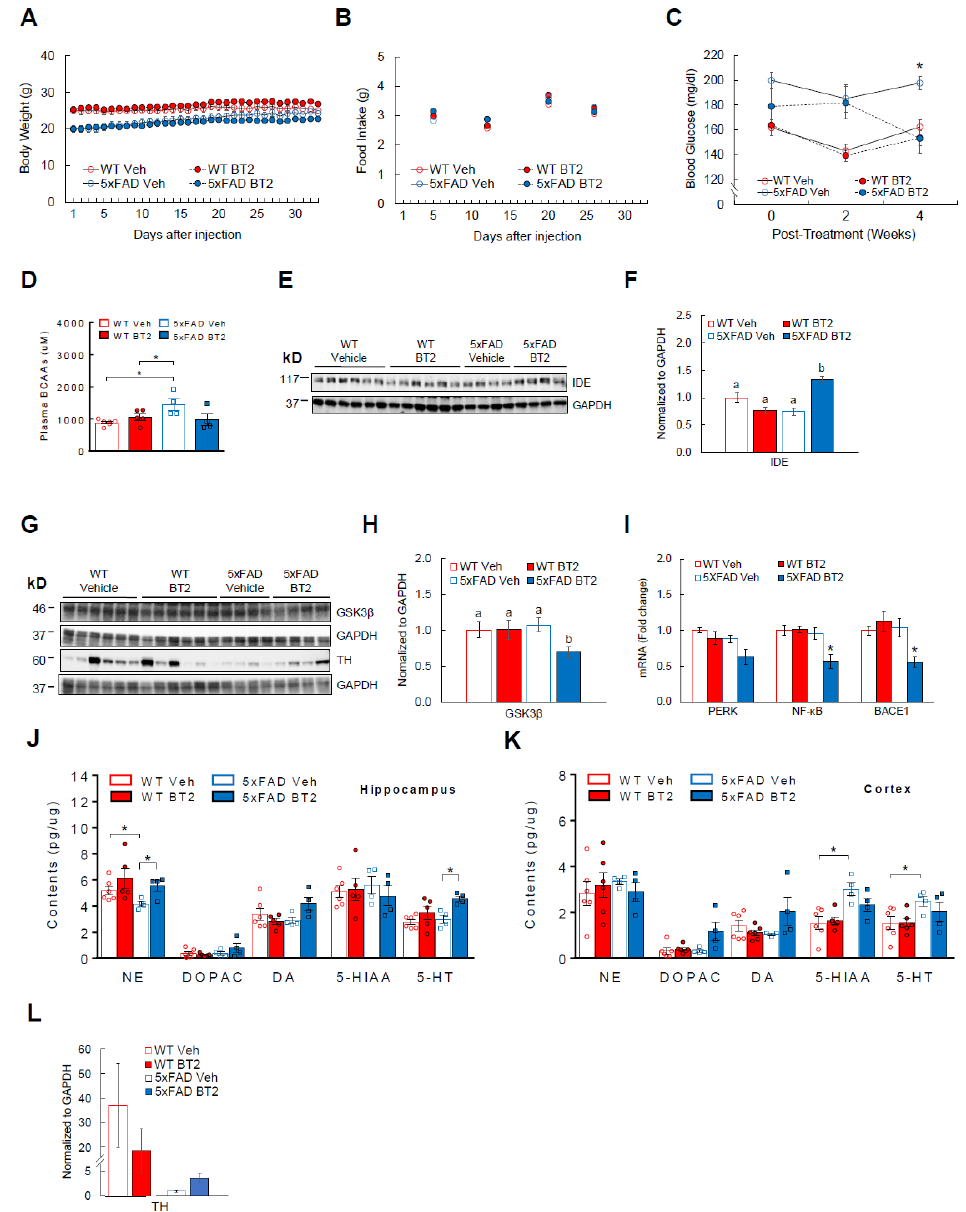
Figure 6. BT2 is effective in alleviating brain pathology and increasing neurotransmitters in 5xFAD mice. WT or 5xFAD mice that are 6 – 8 weeks old were injected with either vehicle or BT2 (40 mg/kg/day) for one month. Animals were single-housed during the experiment. ( A ) Daily body weight. ( B ) Weekly food intake. ( C ) Blood glucose at baseline and at two and four weeks post-treat- ment. ( D ) Plasma BCAA levels at baseline and post-treatment. ( E ) Western blots for IDE in the cor- tex. ( F ) Protein analysis of IDE. ( G ) Western blots for GSK3β in the cortex and tyrosine hydroxylase (TH), the rate-limiting enzyme for catecholamine synthesis, in the hippocampus. ( H ) Protein expres- sion of GSK3β. ( I ) Hippocampal mRNA abundance of markers for ER stress (PERK), inflammation (NF- κB), and amyloid synthesis (BACE1; also known as β -secretase), normalized to B2M. ( J ) Con- centration of neurotransmitters (NE, DA, 5-HT) and their metabolites (DOPAC, 5-HIAA) measured in the hippocampus and ( K ) Cortex. ( L ) TH protein expression in the hippocampus. WT vehicle or BT2 group ( n = 6/group); 5xFAD vehicle or BT2 group ( n = 4/group). * p < 0.05. Groups with different letters are significantly different from each other with p < 0.05.